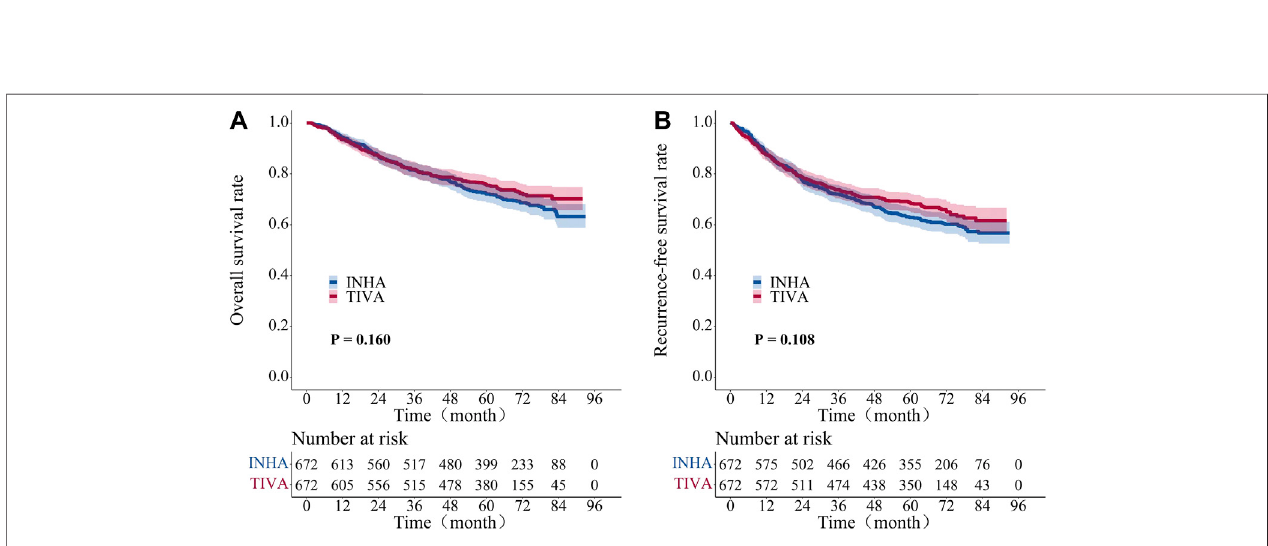
FIGURE 3 | Kaplan – Meier survival curve for overall survival and recurrent-free survival in propensity-matched cohort patient. (A) overall survival rate. (B) recurrent- free survival rate. The Log-rank test was employed to evaluate the difference between the groups.